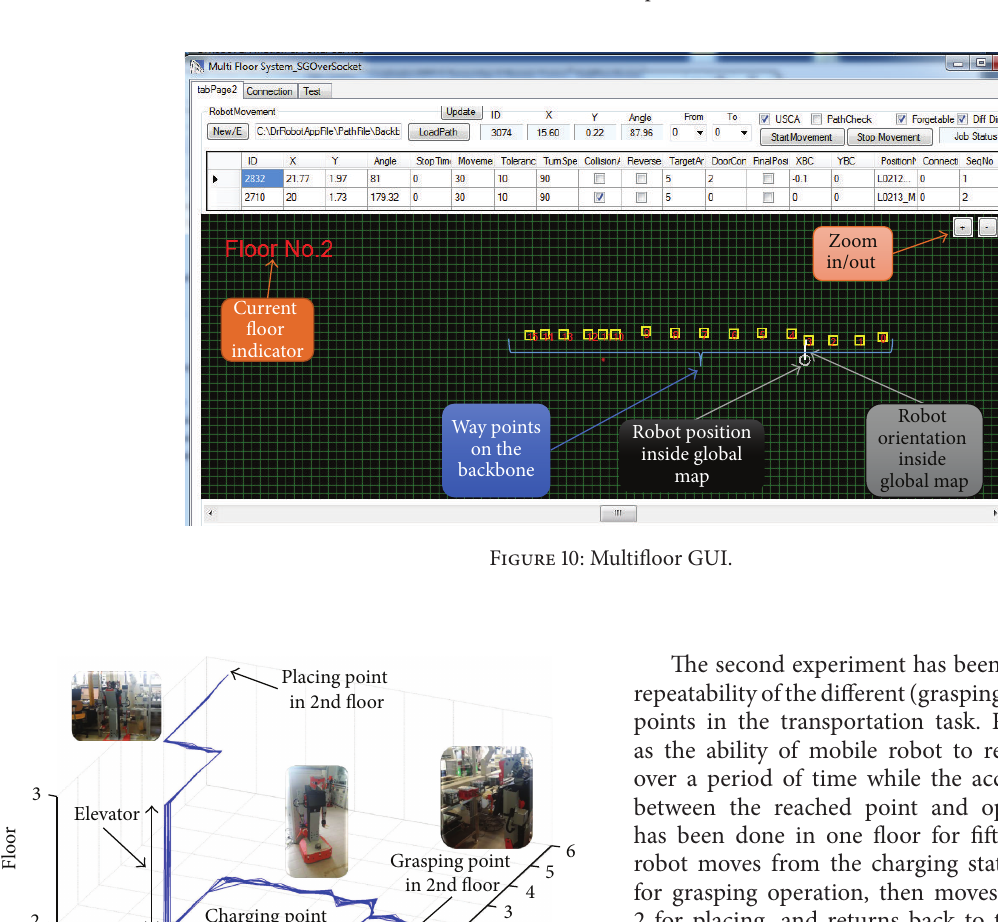
Figure 9: MFS and on-board computer client/server sockets.